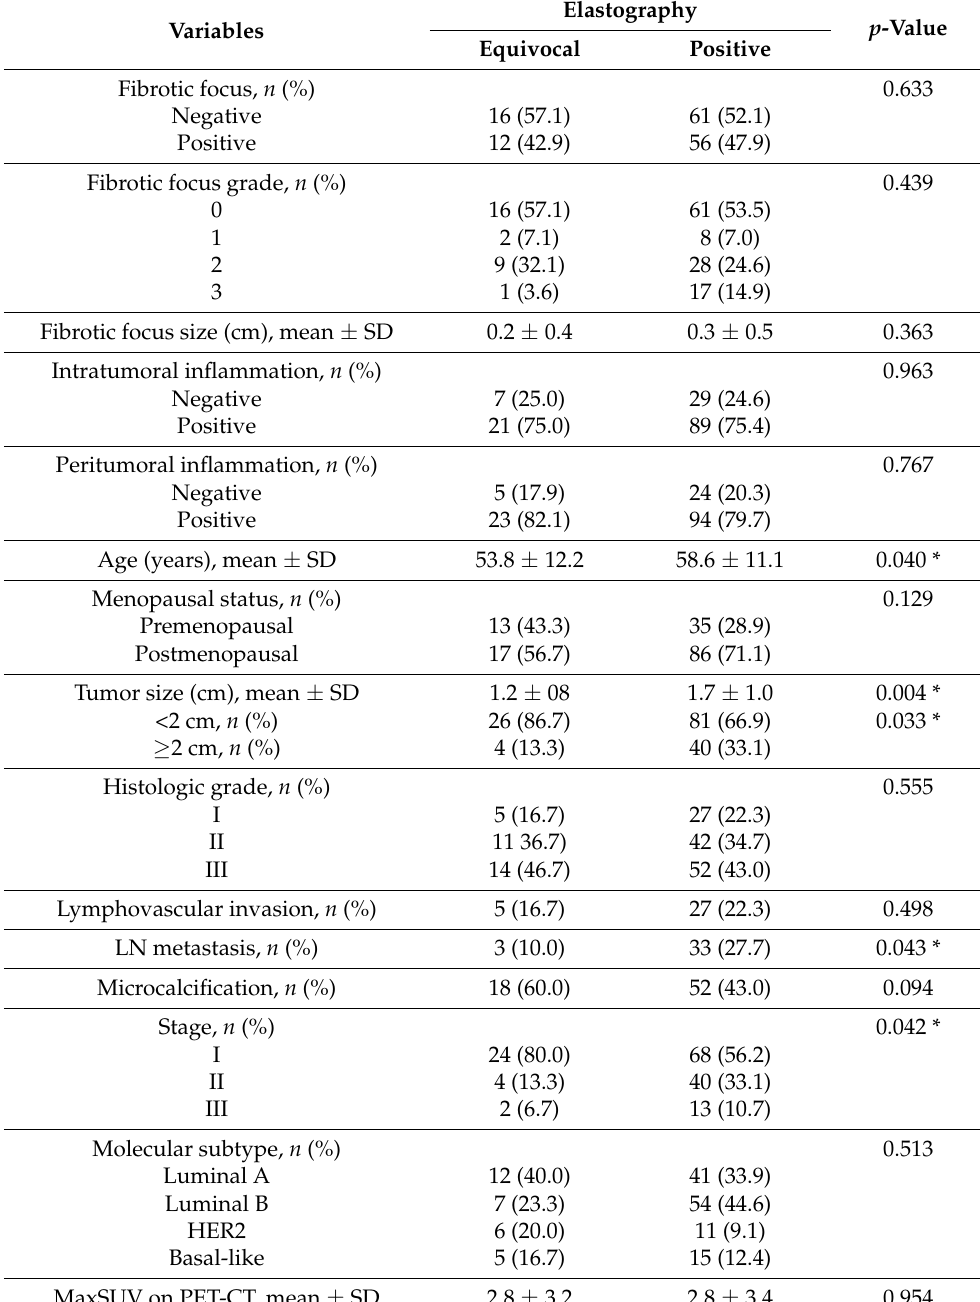
Table 2. Association between the elastographic findings and fibrotic focus, and clinicopathological characteristics of breast